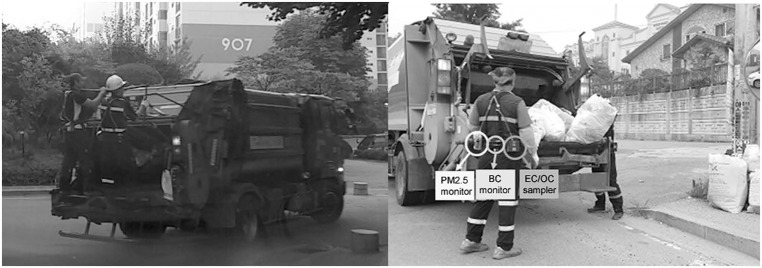
Photographs of municipal household waste-collecting activities.Left: Riding on the rear of a truck. Right: Collecting MHW with samplers mounted.